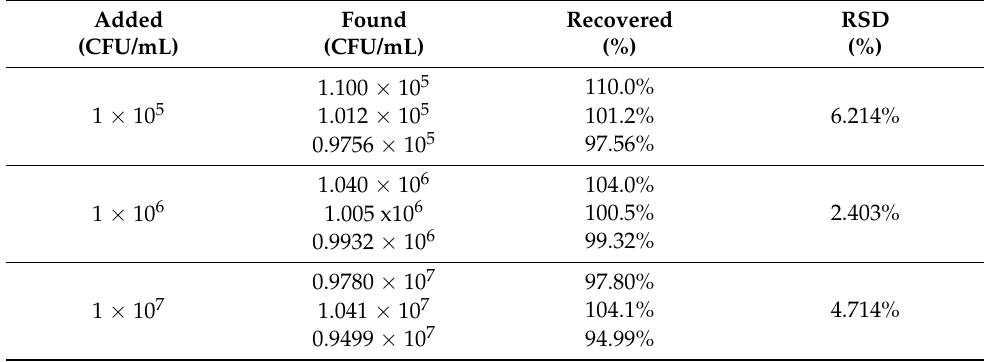
Table 1. Recovery results of spiked salmonella in sheep feces sample.